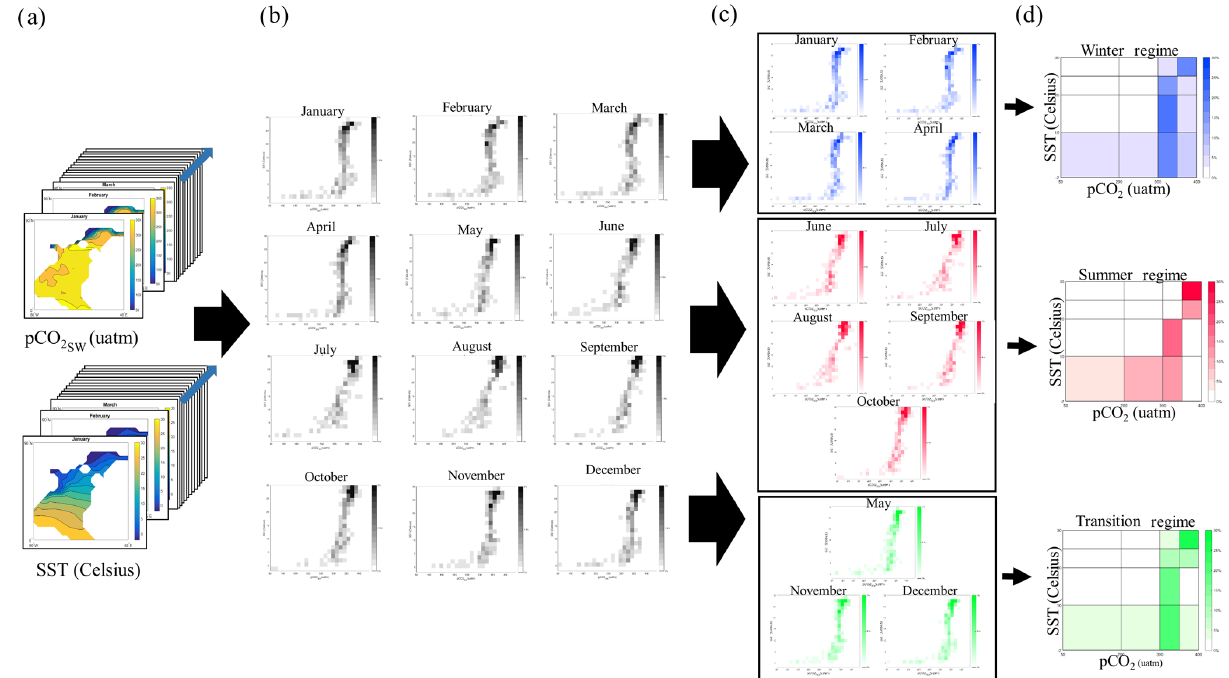
Figure 1. Schematic diagram of the clustering methodology used in this paper: (a) 12-monthly mean climatological year data of two variables, p CO 2 and SST, (b) monthly 2-D histograms, (c) clustering of the 2-D histograms into groups by similarity in the bivariate distributions, and (d) clusters resulting when k = 3 is assumed.